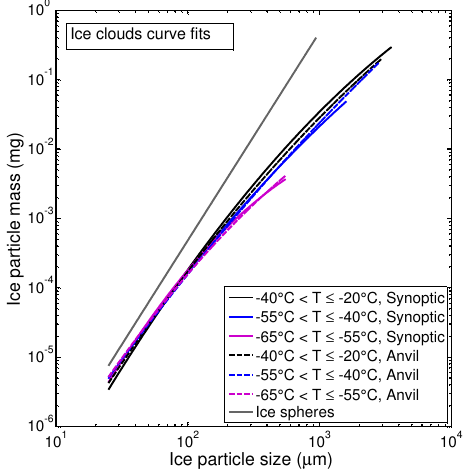
Figure 4. Comparison of all the curve fits in Table 1 for each tem- perature regime (indicated by color) and cloud type (indicated by line type; solid or dashed). The anvil and synoptic curve fits are very